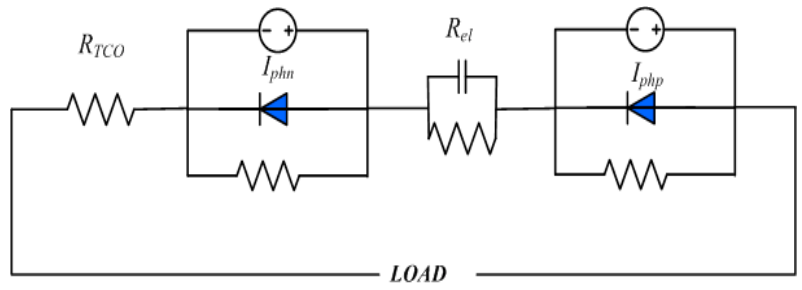
Figure 2. The simplified equivalence circuit of the pn-DSC.